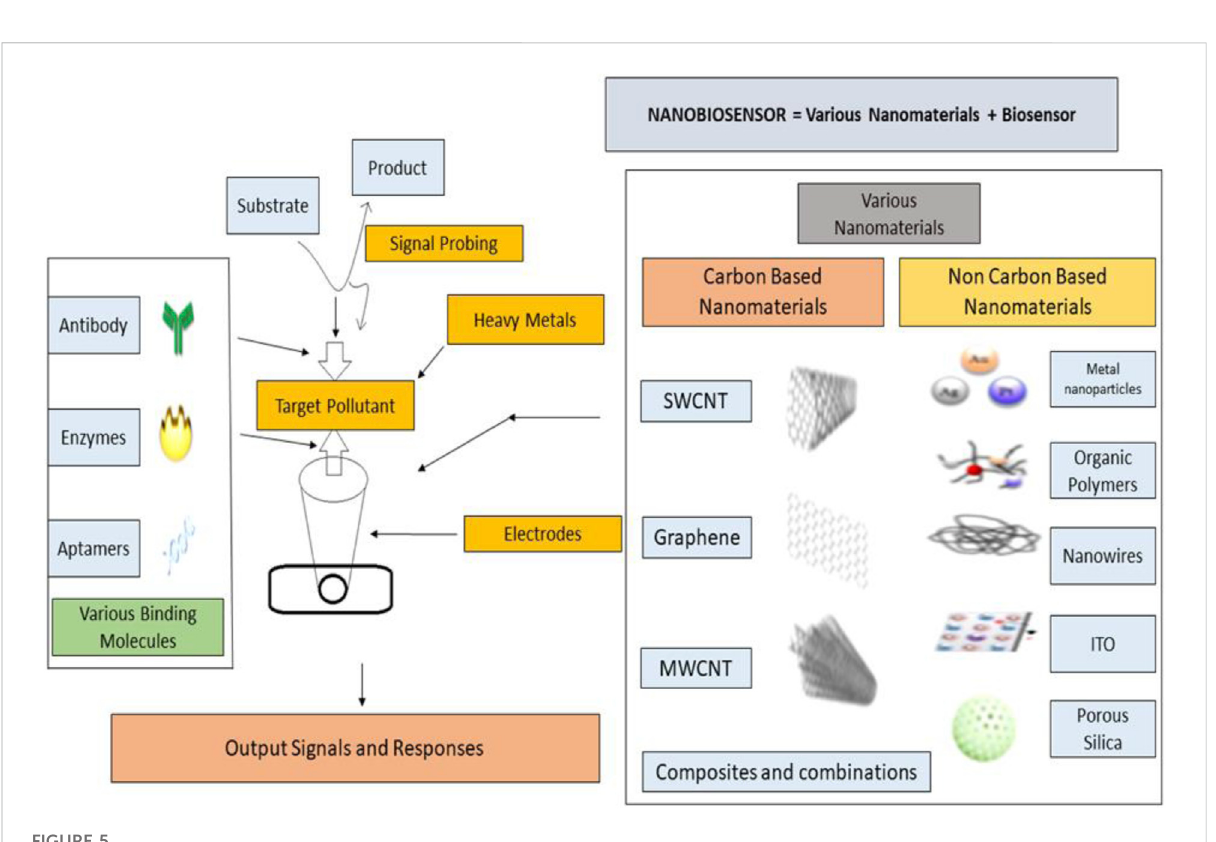
FIGURE 5 Nanobiosensor technology for detection of various environmental